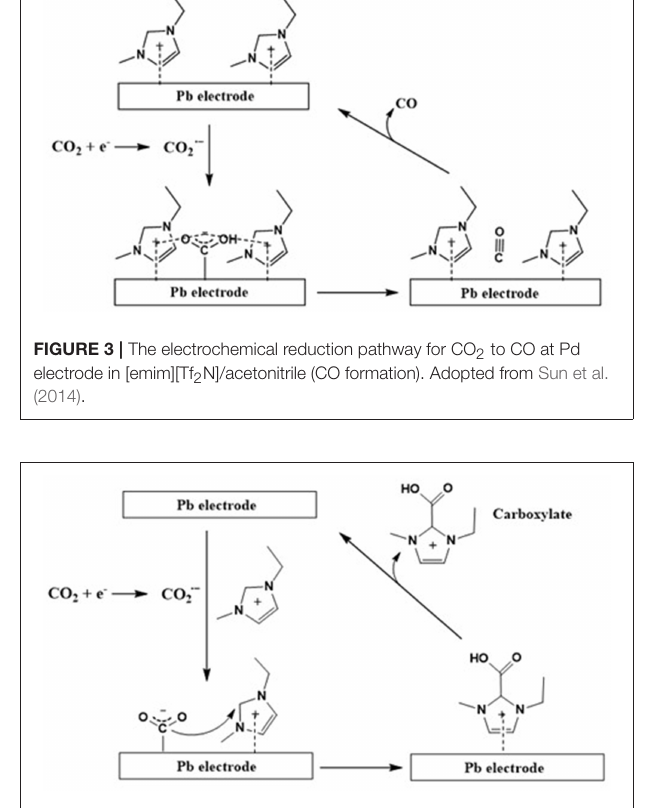
FIGURE 4 | The electrochemical reduction pathway for CO 2 to CO at the Pd electrode in [emim][Tf 2 N]/acetonitrile (imidazolium carboxylate formation). Adopted from Sun et al.